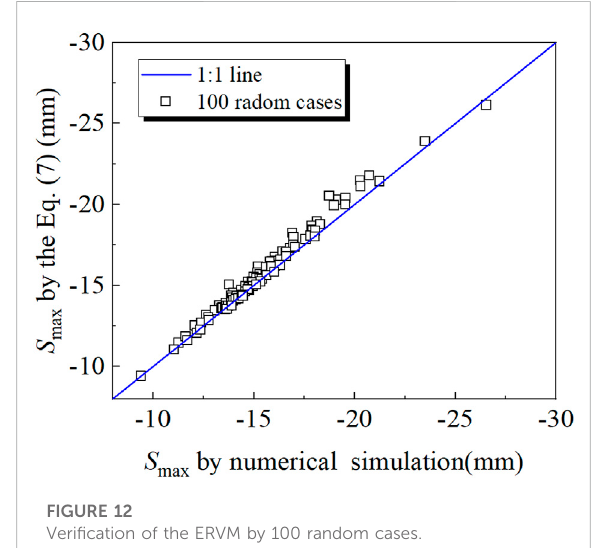
FIGURE 10 Typical mesh and model domain for example II.